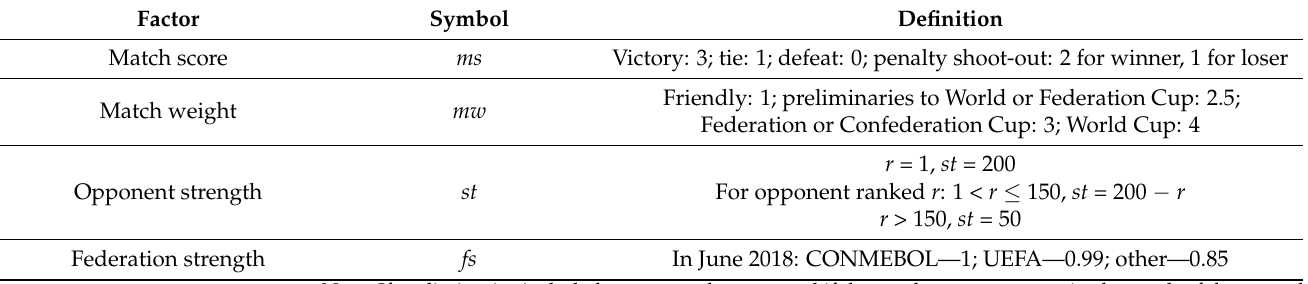
Table 1. Factors affecting the scores for individual